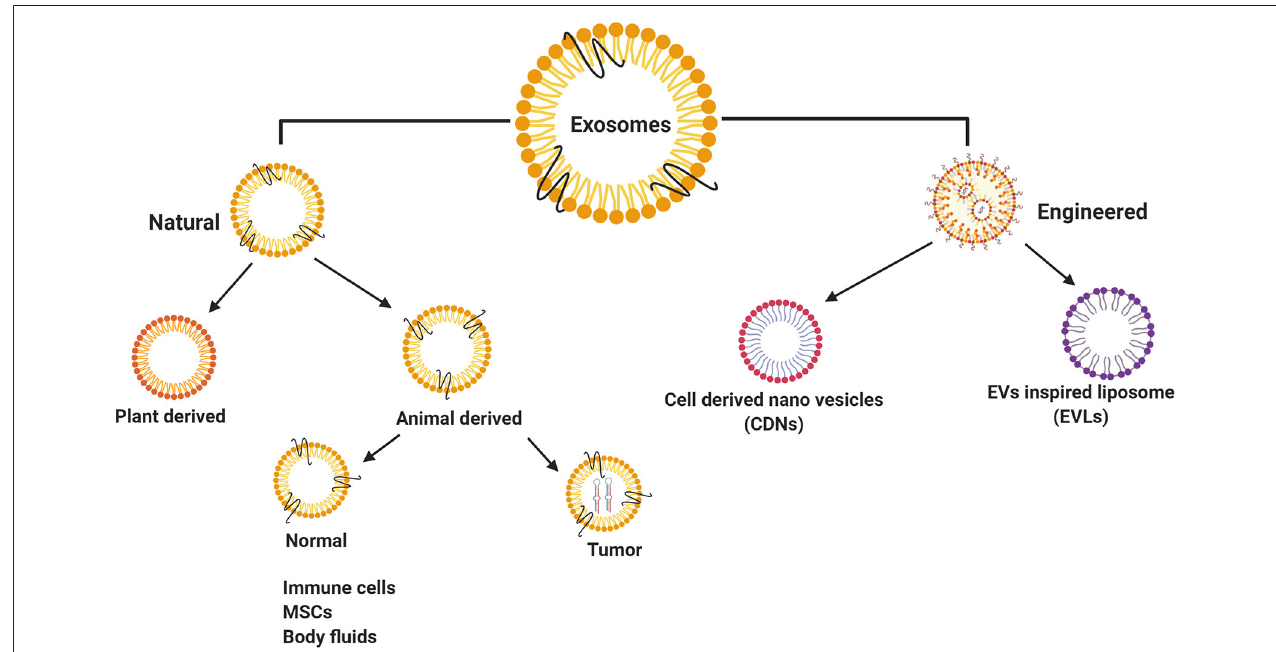
FIGURE 2 | Classification of exosomes isolated from different resources. Natural exosomes have showed in animal/human derived exosomes, plant derived exosomes and engineered